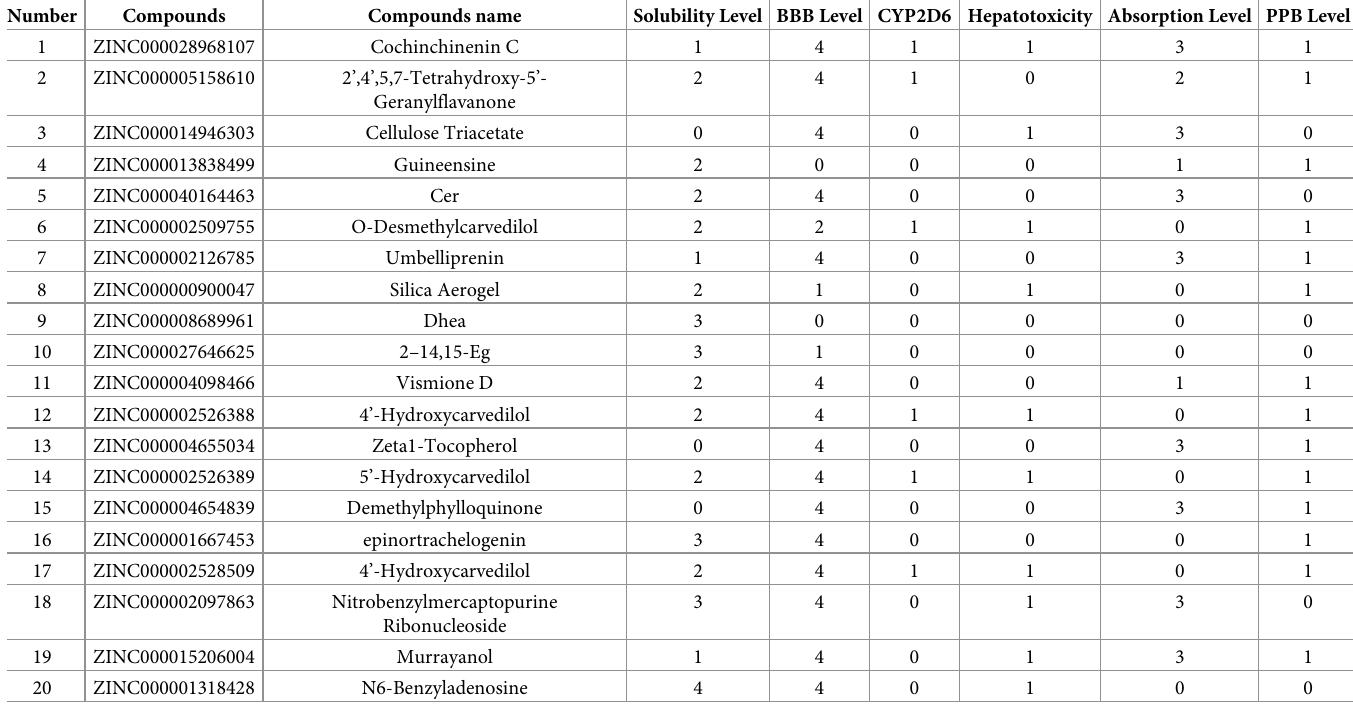
Table 2. Adsorption, distribution, metabolism, and excretion properties of